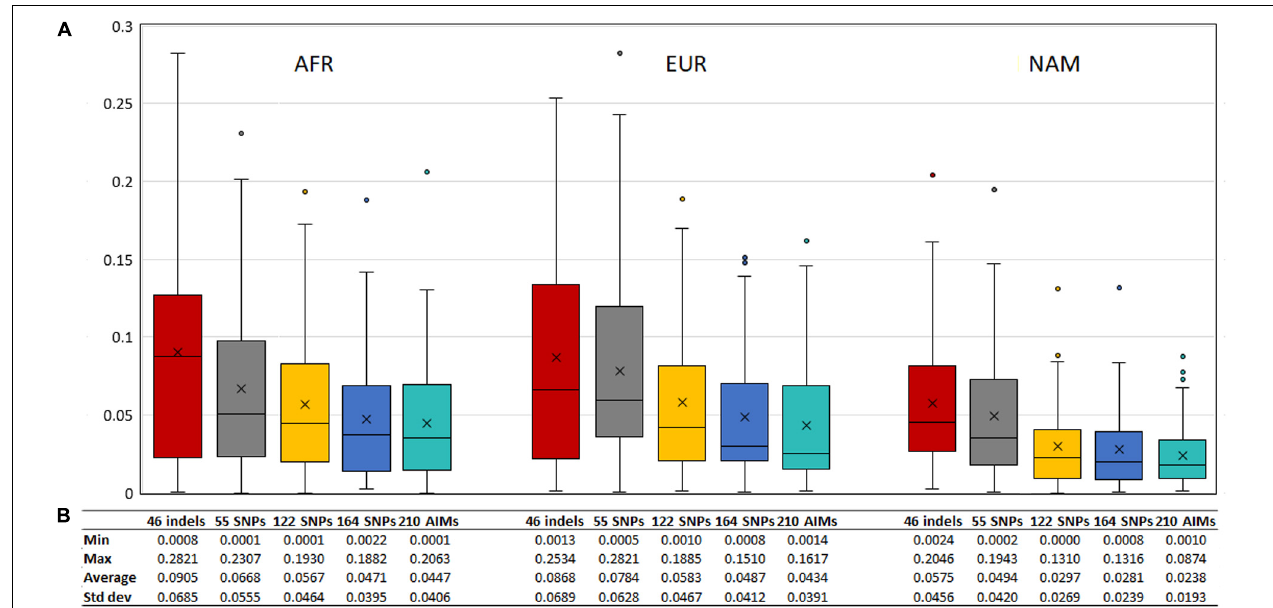
FIGURE 13 | (A) Box and whiskers plot of the absolute differences between the ancestry values obtained for siblings based on results with the five AIM sets. See Figure 11 for the explanation of the Box and whiskers plot. (B) The minimum, maximum, average values, and the respective standard deviations are also presented for each panel and component.